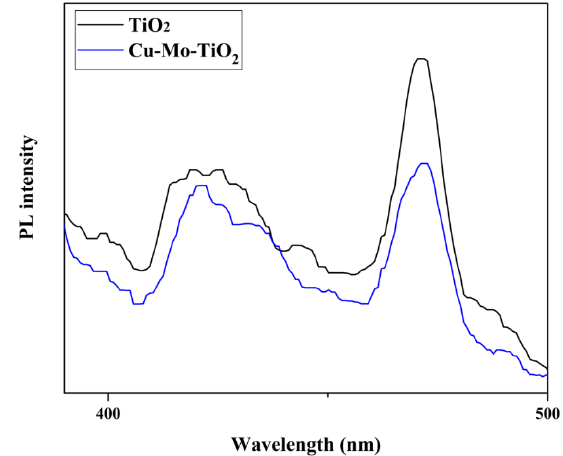
Figure 23. PL spectra of TiO 2 and Cu ‐ Mo ‐ TiO 2 .